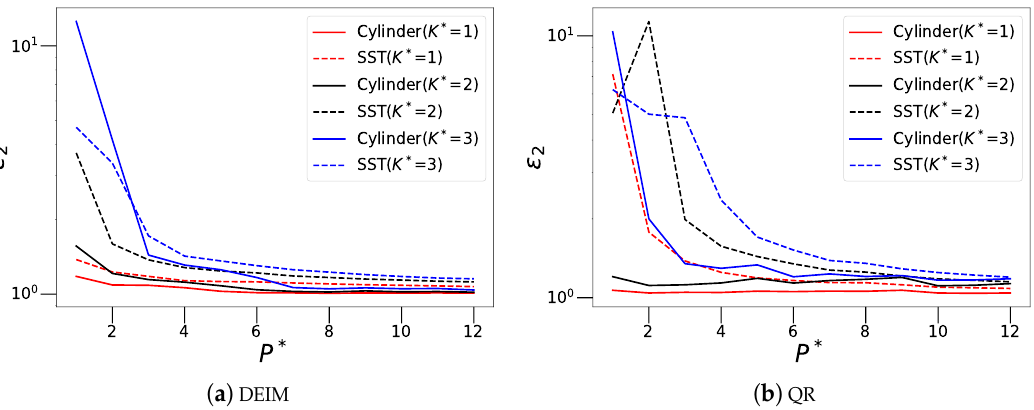
Figure 18. Comparison of relative error ( (cid:101) 2 ) decrease with increasing sensor budget for both wake and SST data. The figure shows three curves for different values of K ∗ = 1,2,3 for both DEIM ( a ) and QR-pivoting ( b ) based sensor